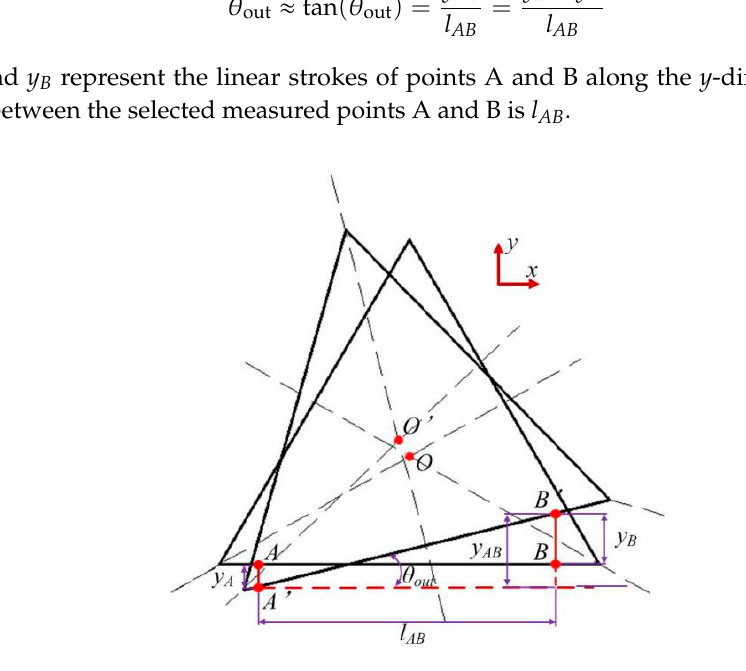
Figure 8. Schematic diagram of the computation of rotational angle.